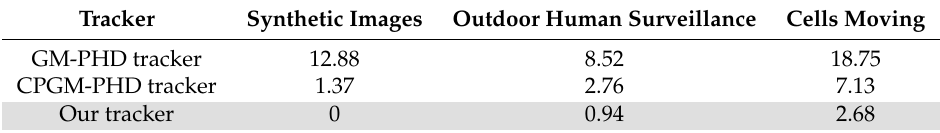
Table 2. Mismatch rate (MMR: %) comparison of the GM-PHD tracker, CPGM-PHD tracker and our